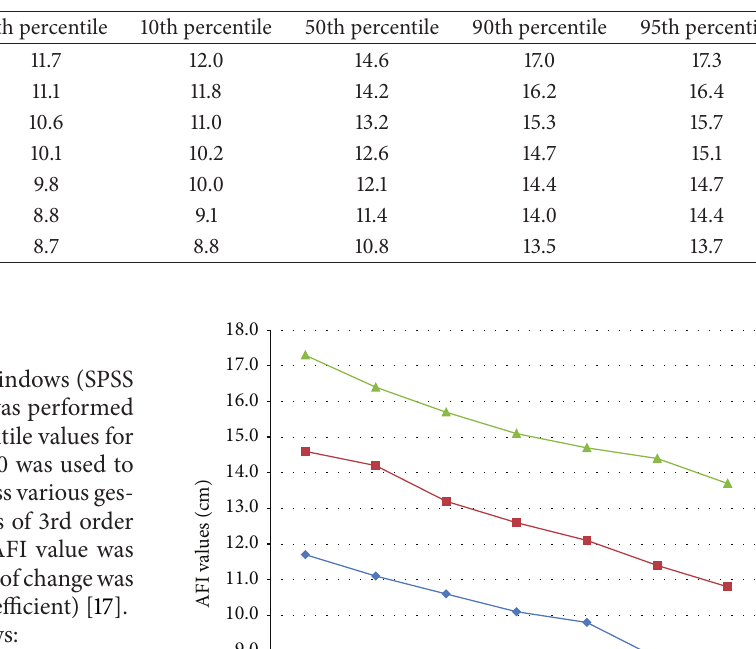
Table 1: AFI values from 34 to 40 weeks; mean, standard deviation, and percentile values (all in centimeters).